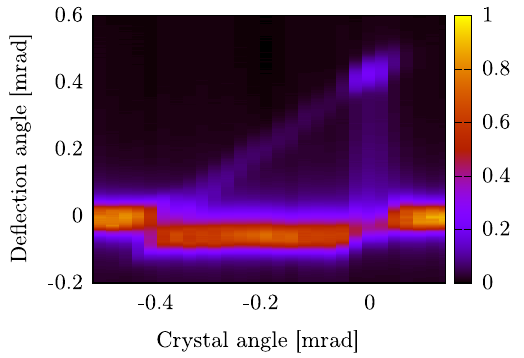
FIG. 8. The probability density of the deflected particles when the crystal is in the channeling orientation for the different energies in the